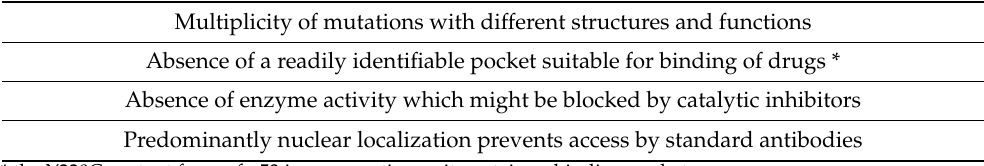
Table 1. Reasons why mutant p53 is difficult to